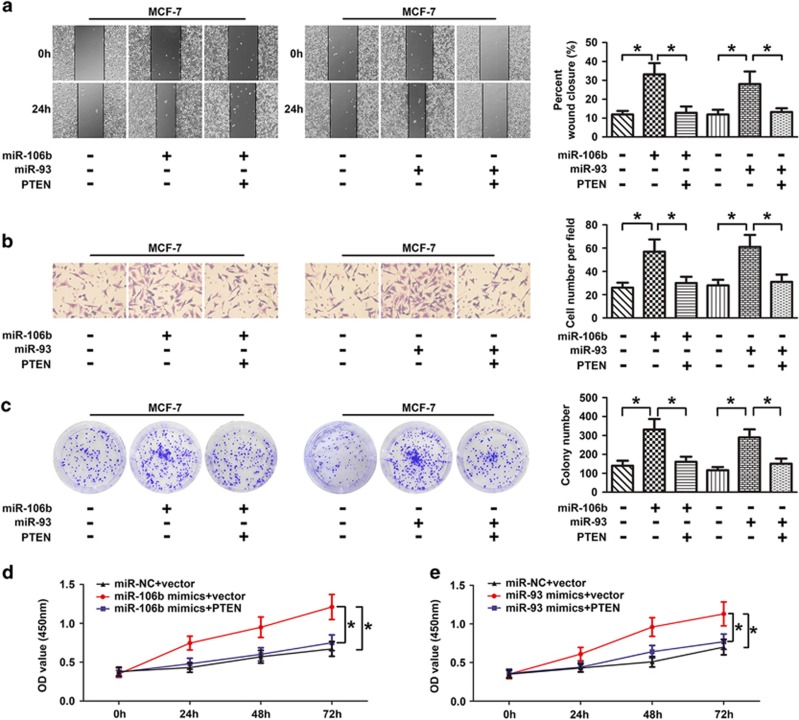
MiR-106b and miR-93 targeted PTEN to promote cell progression in MCF-7 cells. (a-e) MCF-7 cells were co-transfected with miRNA mimics (miR-NC, miR-106b mimics or miR-93 mimics) and the target mRNA (control vector or PTEN). Upregulation of PTEN blocked the effect induced by overexpressed miR-106b or miR-93 in MCF-7 cells. Representative results of wound-healing assay (a), transwell assay (b), colony formation assay (c) and CCK8 assay (d and e) in MCF-7 cells. Each experiment was independently repeated at least three times. Data were presented as mean±S.D. (*P<0.05)